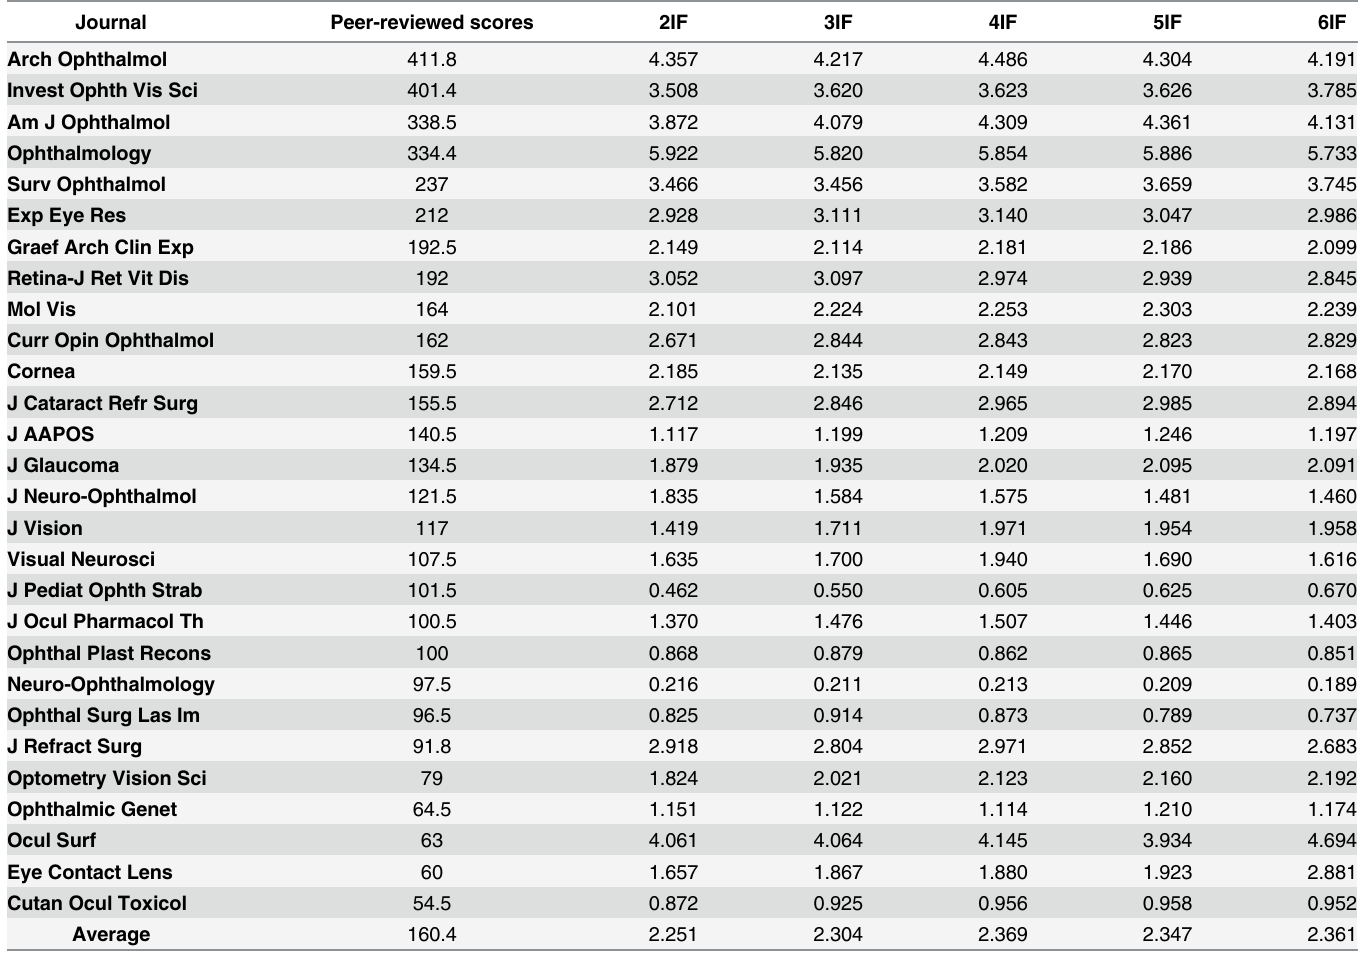
Table 1. Peer-reviewed scores of 28 ophthalmologic journals and impact factors with different citation time windows in